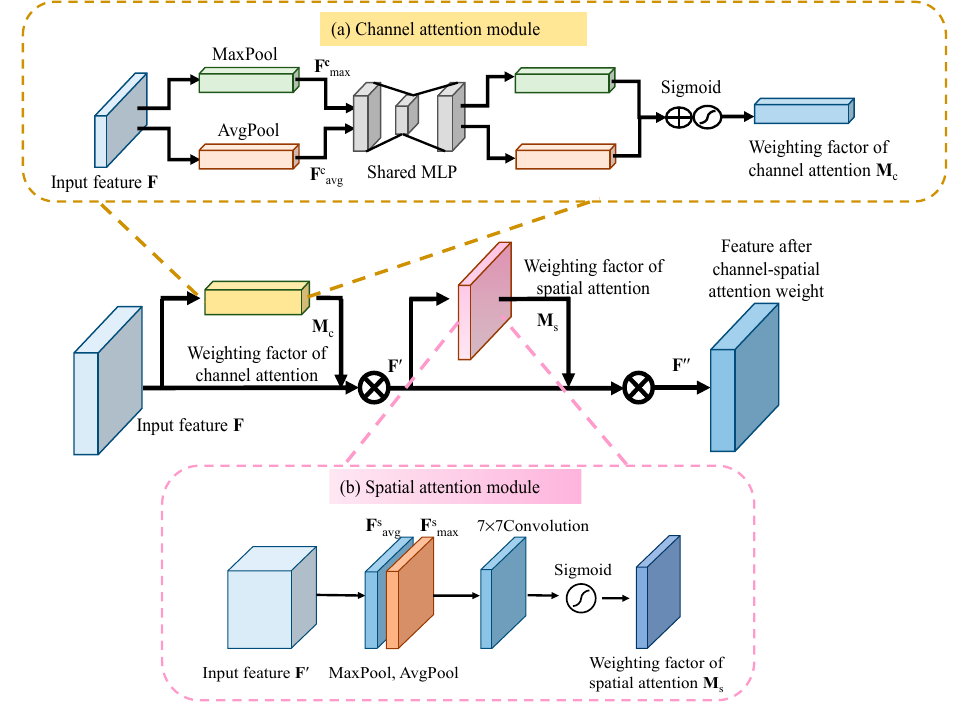
Figure 3. Channel-spatial attention module.